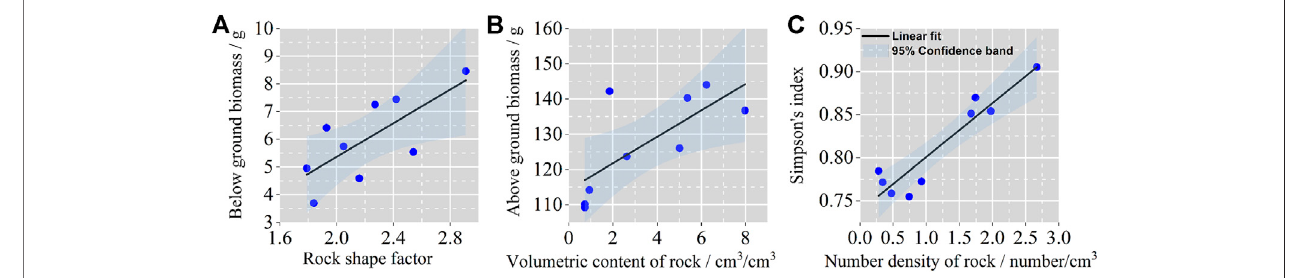
FIGURE 5 | Relationship between the belowground biomass, aboveground biomass, Simpson ’ s index and rock fragment characteristics. The black lines indicate the regression fi tting lines, and the light blue shaded area indicates the 95% con fi dence interval of the